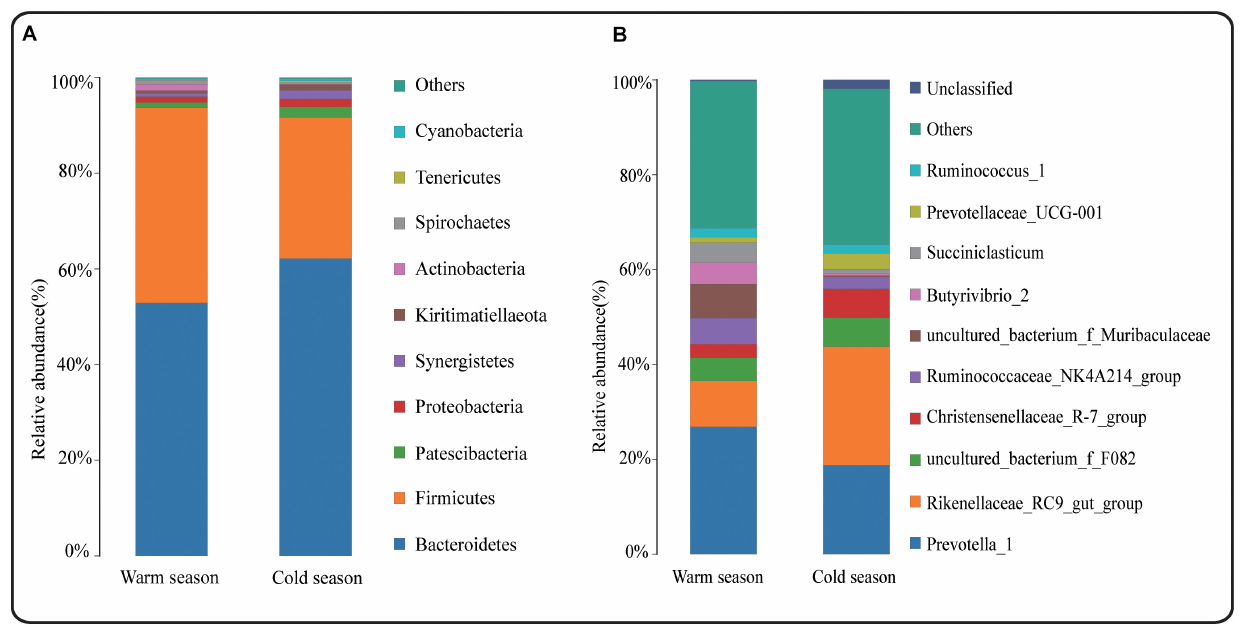
a heat map (correlation threshold > 0.5) ( Figure 6 and